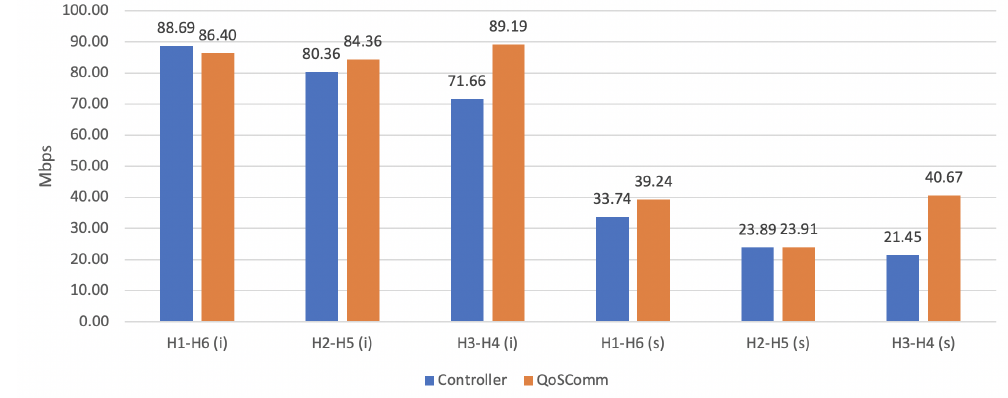
Figure 5. IPERF UDP data transfer comparison (average mbps). Tests execution: (i)